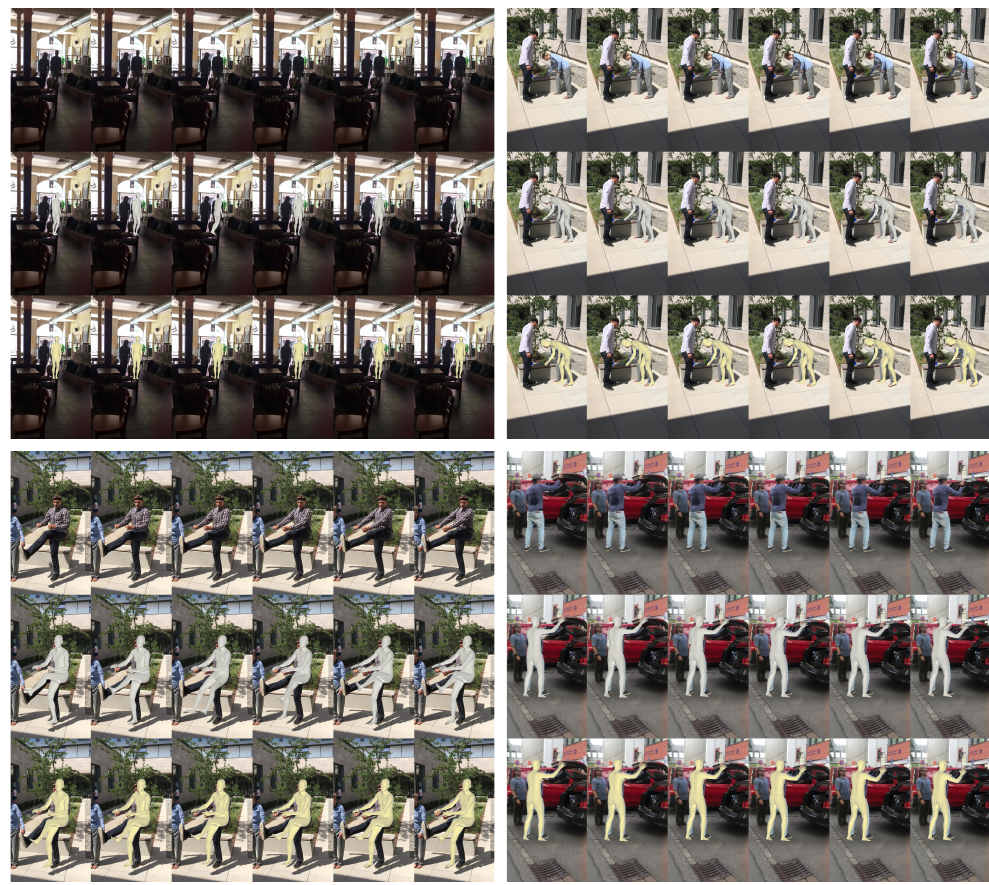
Figure 8. Input images ( top ) and reconstruction results of SPIN ( middle , gray SMPL mesh) and HPR-Net ( bottom , yellow SMPL mesh) on the 3DPW